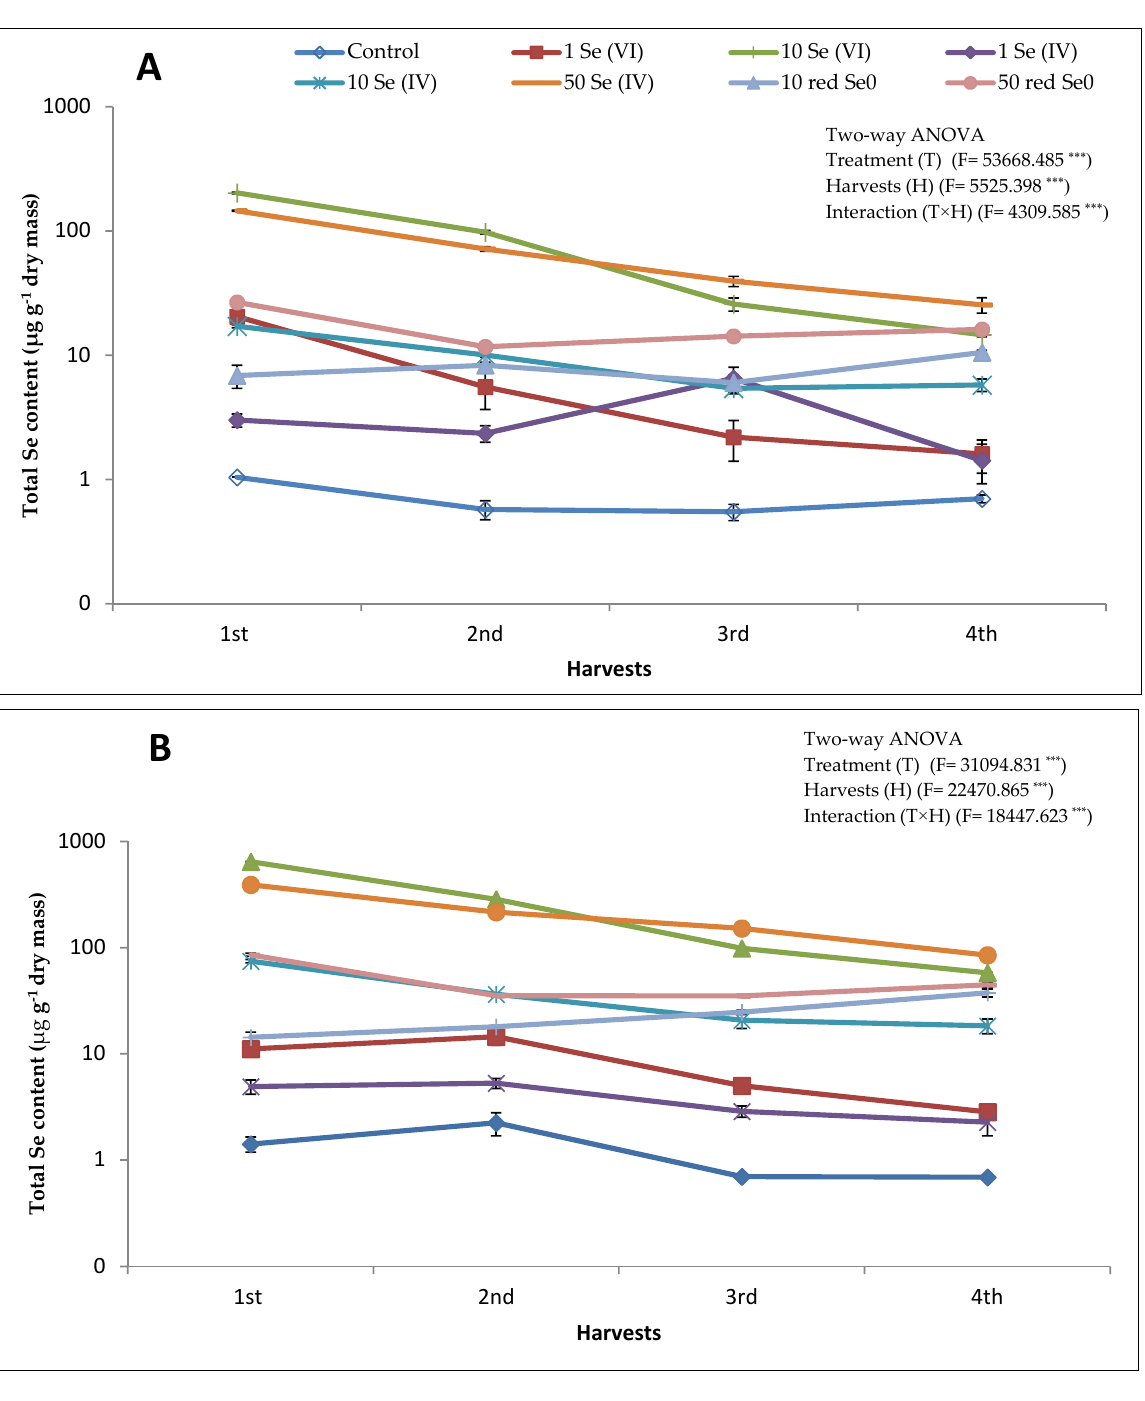
Figure 1. Total selenium (Se) content in alfalfa aboveground biomass ( A : stem; B : leaves) fertilized with different Se forms (i.e., Se (VI), Se (IV) and red Se 0 ) at different concentrations (1, 10, and 50 mg kg −1 for ionic forms and 10 and 50 mg L −1 for red Se 0 ) within four consecutive harvests with 30-day intervals. Alfalfa plants that received 50 mg kg −1 Se (VI) died two weeks after seed germination. Data are means ± SD ( n = 6). *** significant according to Tukey’s test ( p ≤ 0.001) Overall, evolution of the total Se content in alfalfa leaves differed slightly from stem (Figure 1B). For instance, the application of Se (VI) at the rate of 10 mg kg −1 resulted in the highest total Se content in leaves in the 1st and 2nd harvests, while the highest total Se content in the 3rd and 4th harvests corresponded to the 50 mg Se kg −1 Se (IV). In the treat- ment of 10 mg kg −1 Se (VI) and 50 mg kg −1 Se (IV) a linear reduction in total Se content was detected within the four harvests. However, the other treatments hesitantly affected the total Se content in leaves. Interestingly, upon the application of 10 mg L −1 red Se 0 , the total Se content in leaves increased gradually from the 1st harvest (14.3 µg g −1 ) to the 4th harvest (37.5 µg g −1 ). Despite the application of 50 mg L −1 red Se 0 it did not show the same trend as the 10 mg L −1 red Se 0 , it exhibited a reduction in the total Se content from the 1st to the 3rd harvest then increased again in the 4th harvest. However, the reduction in the total Se content was 47.8% for the treatment of 50 mg L −1 red Se 0 while for the 10 mg kg −1 Se (VI) and 50 mg kg −1 Se (IV) treatments was 91.0 and 78.3%, respectively. 2.1.2. Selenium Forms Selenium forms in alfalfa aboveground part were identified and quantified with the external calibration method from the 1st, 2nd, and 4th harvests. Regarding quality assur- ance, Se-enriched yeast (SELM-1) as a certified reference material was analyzed. The re- covery % of Se from SELM-1 was 80.4% for SeMet. The Se speciation was carried out for the treatments with the highest Se concentration, i.e., 10 mg kg −1 Se (VI), 50 mg kg −1 Se (IV); and 50 mg L −1 red Se 0 , in the 1st, 2nd, and 4th harvests. Based on SAX HPLC-ICP-MS results, inorganic Se (VI) was the dominant peak in water-soluble stem and leaf fractions regardless of the applied Se treatment (Table 1 and Figure S1). However, Se (VI) content drastically declined from the 1st harvest to the 4th one in the treatments of 10 mg kg −1 Se (VI) and 50 mg kg −1 Se (IV). For instance, the stem Se (VI) concentration in the treatment of 50 mg kg −1 Se (IV) decreased from 89.0 µg g −1 (in the 1st harvest) to 5.16 µg g −1 (in the